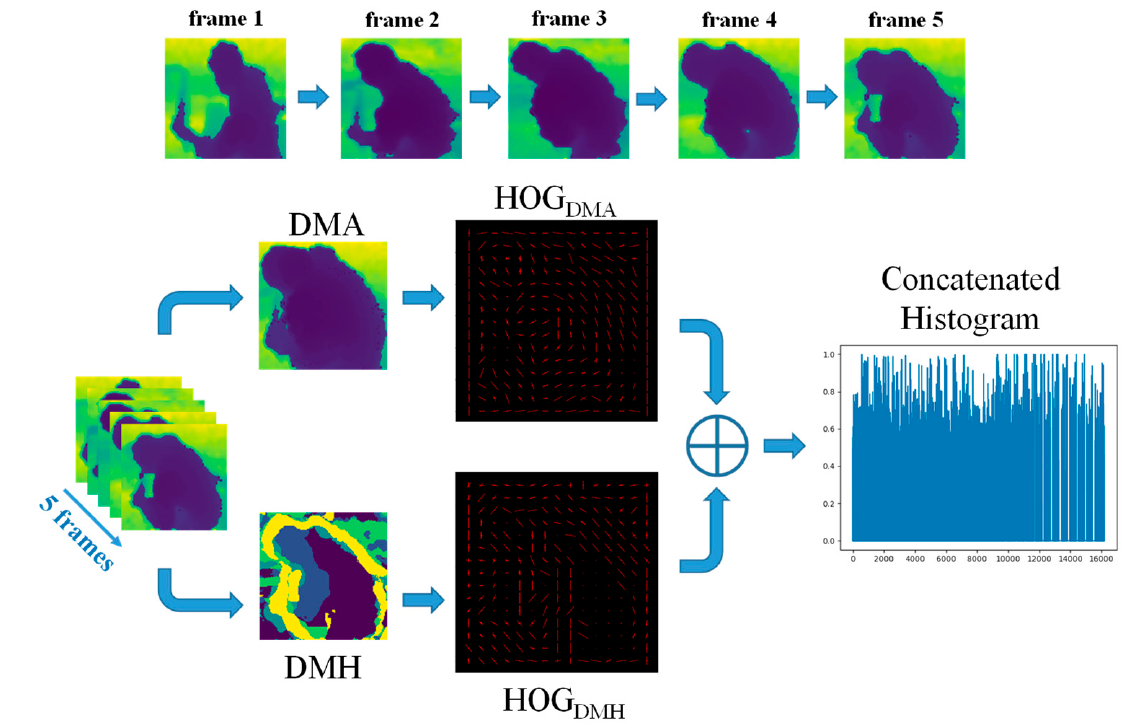
Figure 7. The architecture of feature extraction.